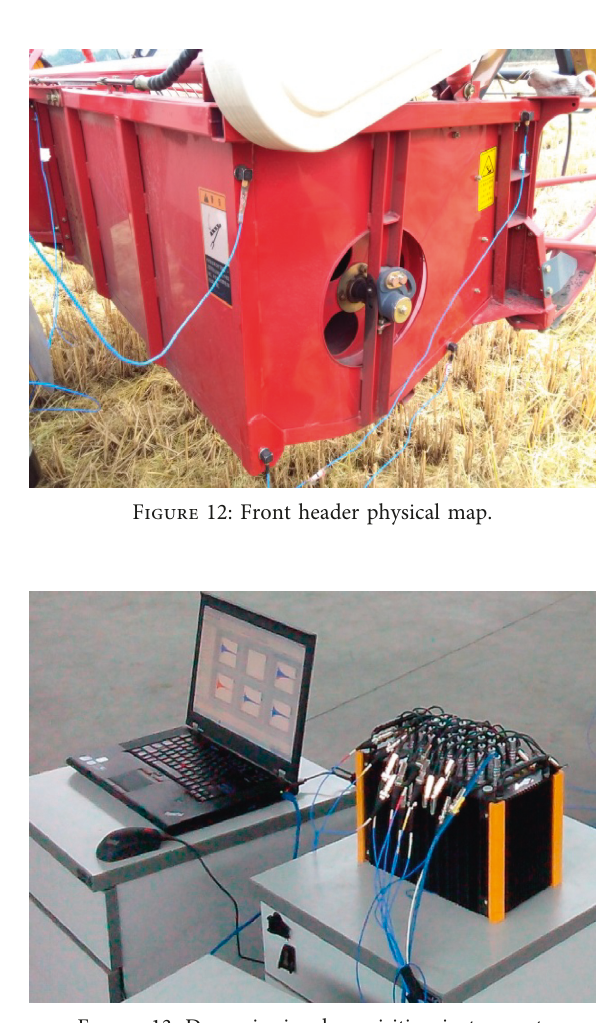
Figure 11: (a) Constraint positions at frame beam and (b) mesh model of the front header.